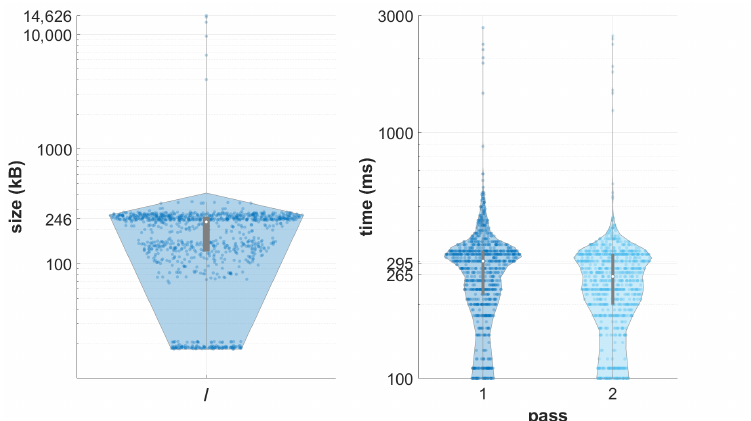
Figure 9. Data retrieval. The left part depicts the test data set; most instances occupied several hundred kB. The right part shows the total retrieval time (from issuing the request to finishing the write of the instance in the VM storage). Results are shown on a logarithmic scale for